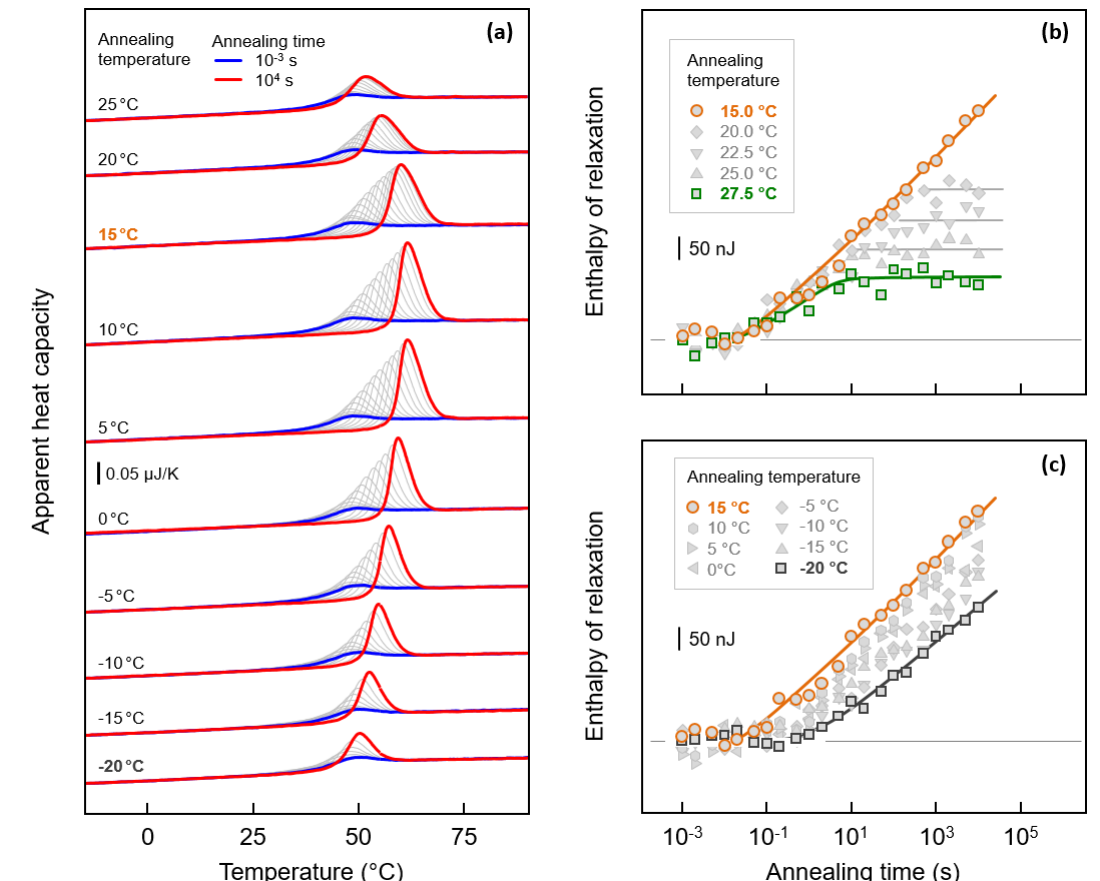
Figure 5. Sets of FSC heating scans, recorded at a rate of temperature-change of 1000 K/s, of PBI annealed at different temperatures between -20 °C (bottom set of curves) and 25 °C (top set of curves) for different time between 0.001 s (blue) and 10,000 s (red) (a) . Before annealing, the sample was cooled from 180 °C, using a rate of 1000 K/s, yielding a fully amorphous sample. Enthalpy of relaxation as a function of the time of annealing at temperatures between 15 and 27.5 °C (b) , and between -20 and 15 °C (c) .